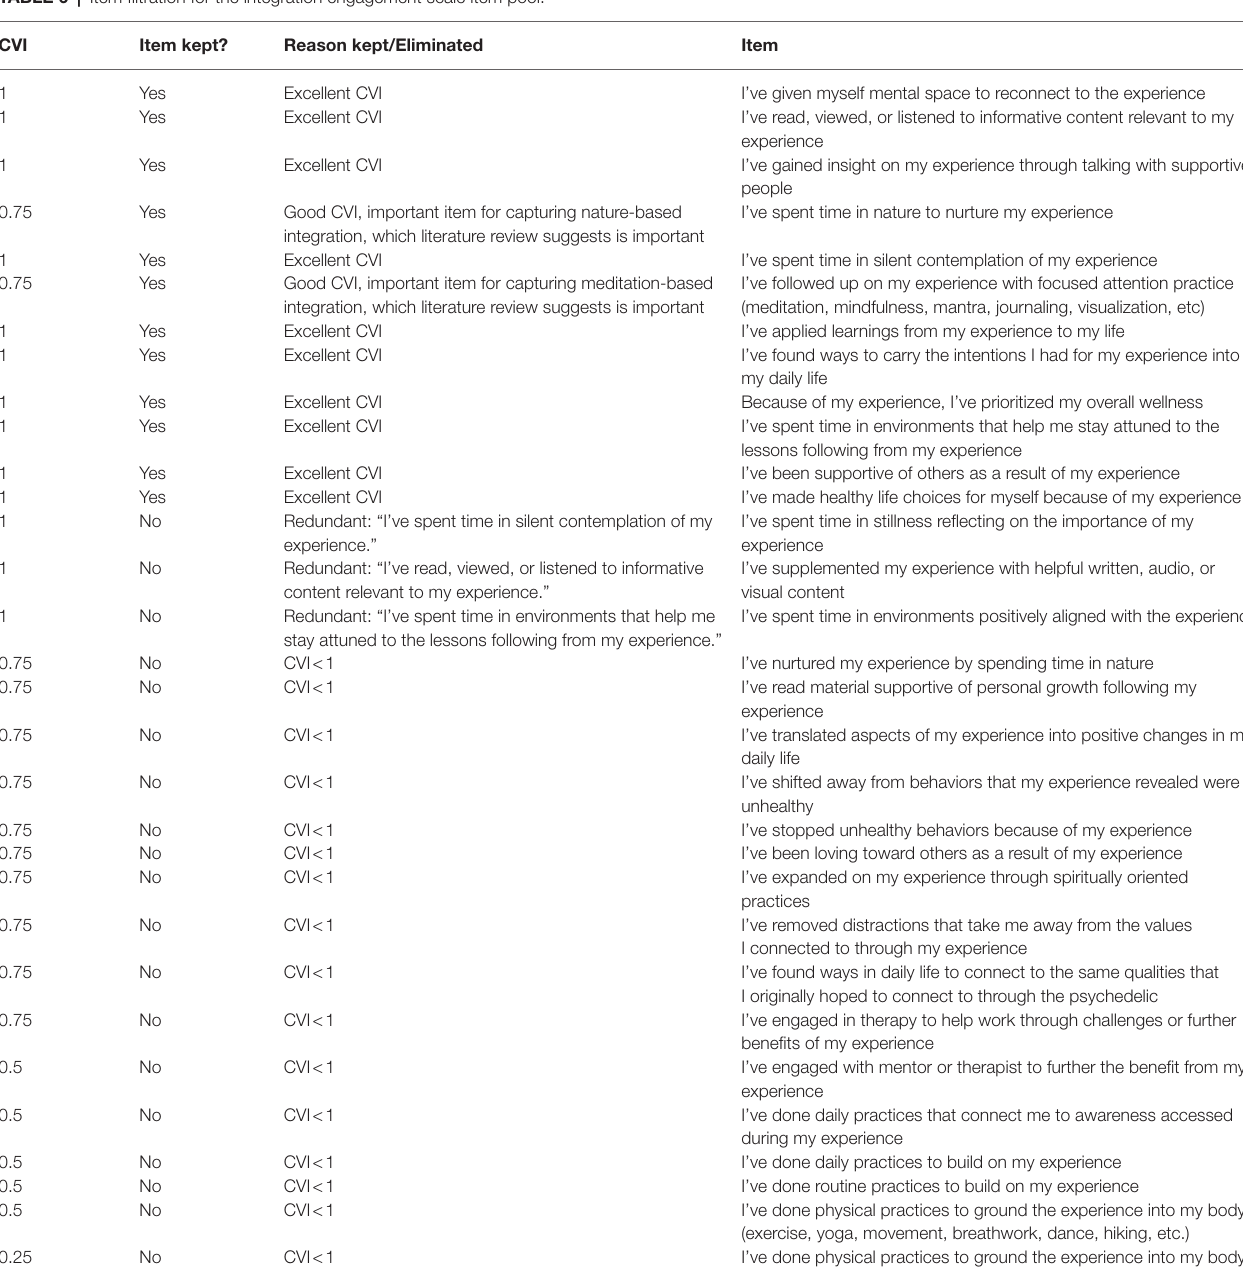
TABLE 6 | Item filtration for the integration engagement scale item pool. CVI Item